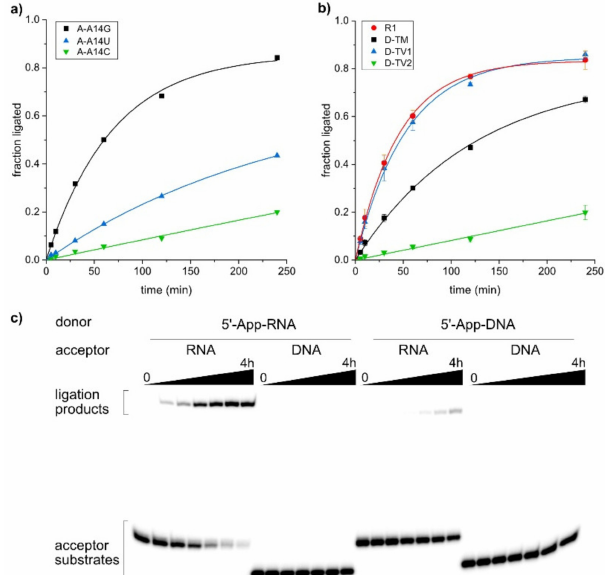
Figure 4. SC9-catalyzed ligation of mutated substrates. ( a ) Kinetic graphs of ligation with mutations of the 3 (cid:48) -terminal nucleotide in the acceptor RNA. ( b ) Kinetic graphs for ligation of transition and transversion mutants of donor RNA (5 (cid:48) -AppG was kept as in parent RNA). See Table 2 for sequences of RNA substrates and corresponding SC9 deoxyribozyme mutants. ( c ) Gel images of ligation tests with DNA / RNA substrate